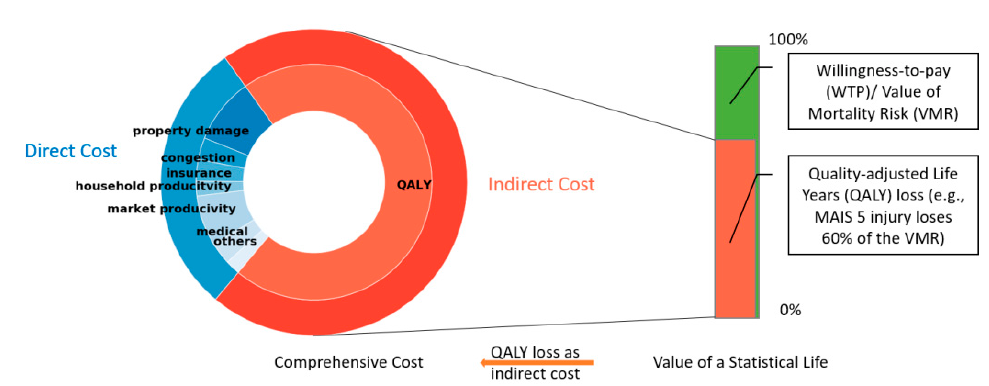
Figure 1. Cost composition and relationship. Note: quality-adjusted life year, QALY; willingness-to-pay,